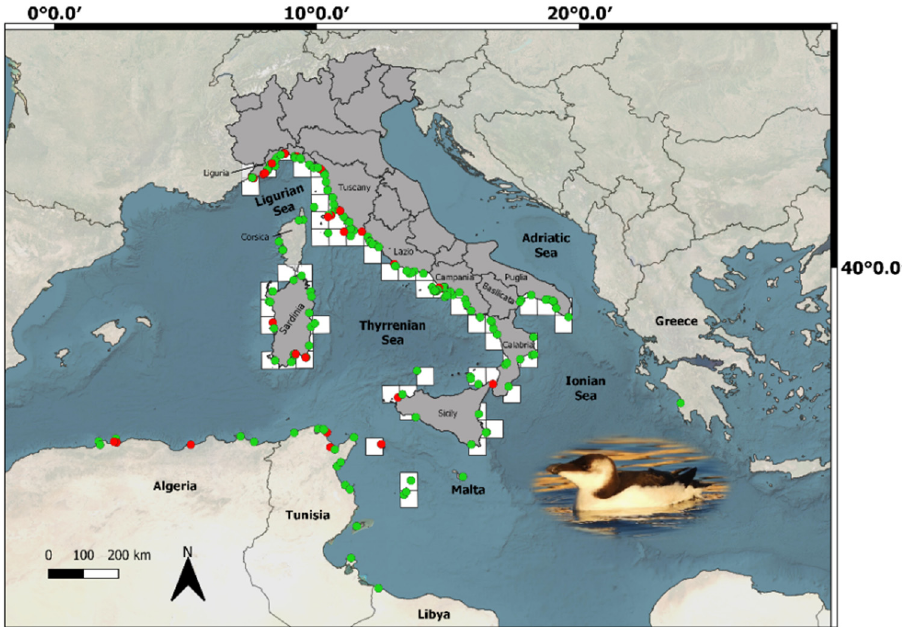
Figure 1. Razorbill observations during November–December 2022 in the central Mediterranean area. Dots represent the community participation in the collection of all records (including possible multiple counts), where alive (green) or dead (red) individuals are indicated. The names of countries, regions and seas are shown on the map. For Italy, the at-sea distribution is also shown for macro areas using a 50 × 50 km vector polygon grid of the EEA reference grid, where white grid cells contain at least a record (photo © Rosario Balestrieri).